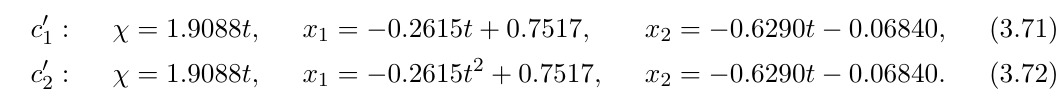
and c 0 linking the two minimum points given 1 2